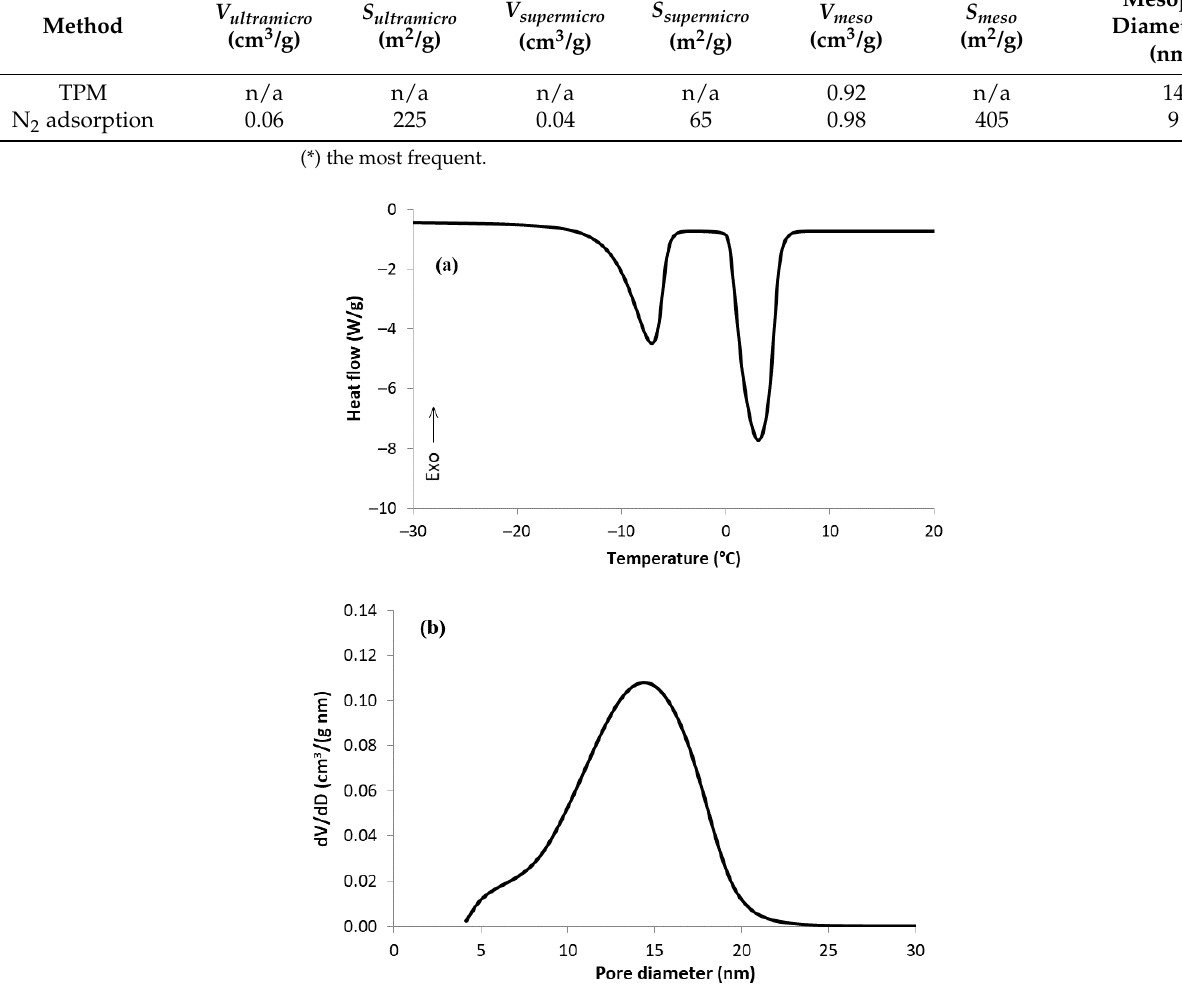
Figure 2. DSC curve of melting ( a ) and pore size distribution from TPM ( b ) of MC-1:2 sample. Table 2. Porous characteristics of MC sample determined by TPM and N 2 adsorption at − 196 °C.